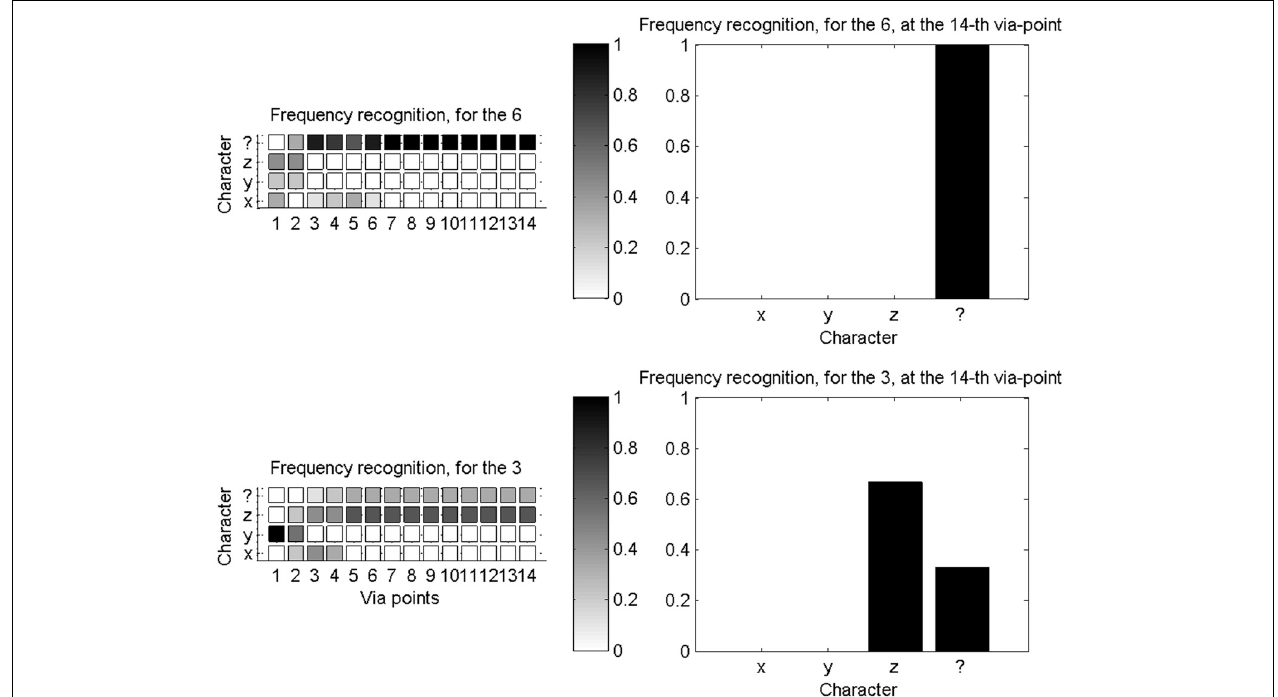
FIGURE 12 | Novelty detection during character recognition. Left column: evolutions of the probability distributions over characters (among “x,” “y,” “z,” and “$”), as the fourteenth first via-points are detected. Right column : final probability distribution over letters after detection of the fourteenth via-point. Top row concerns recognition and